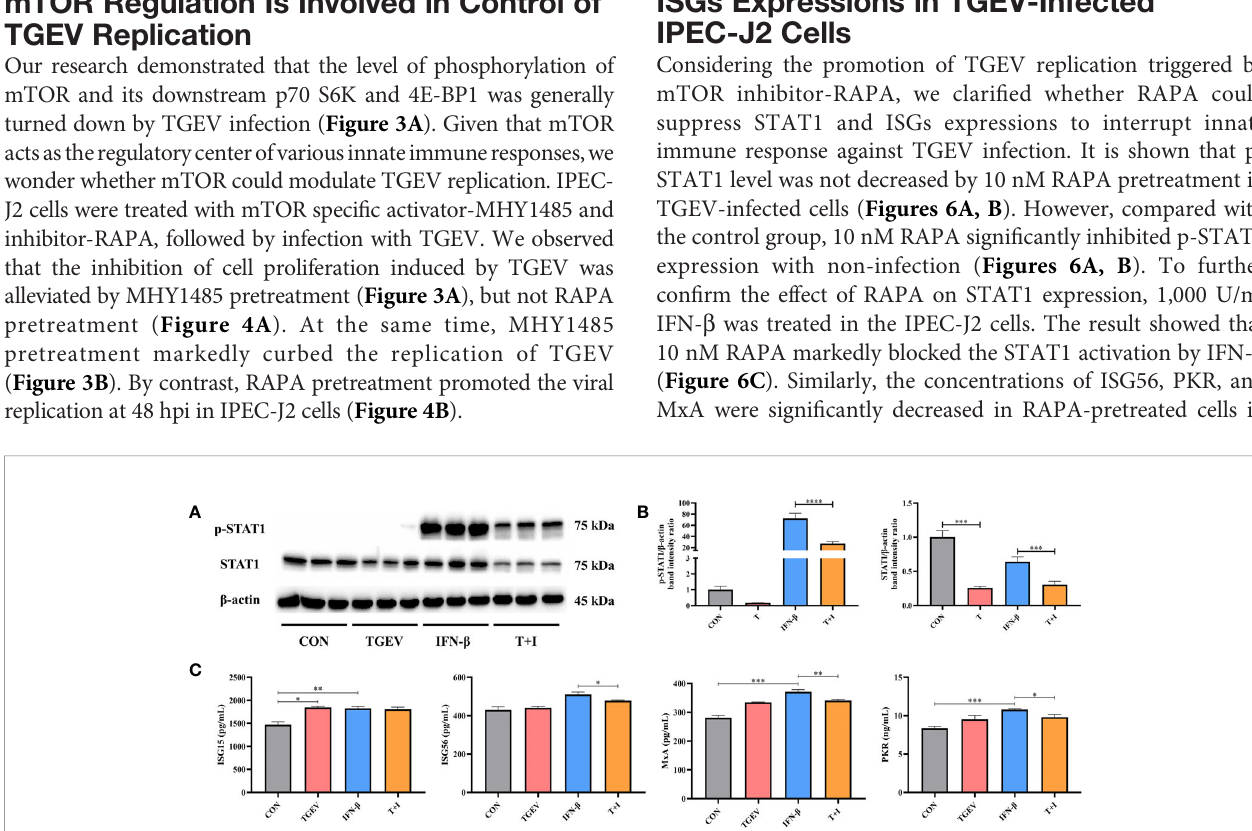
FIGURE 2 | IFN-I signaling pathway was blocked by TGEV infection. (A) Both p-STAT1 and T-STAT1 levels were detected by western blot. (B) Quantitation of bands to demonstrate the protein level of p-STAT1 and T-STAT1. Data express the means ± SEMs (n = 3). (C) The expressions of ISGs (ISG15, ISG56, MxA and PKR) were analyzed via ELISA. Data express the means ± SEMs (n = 3). The symbol * indicates statistically signi fi cant differences ( P < 0.05), ** P < 0.01, *** P < 0.001 and **** P <